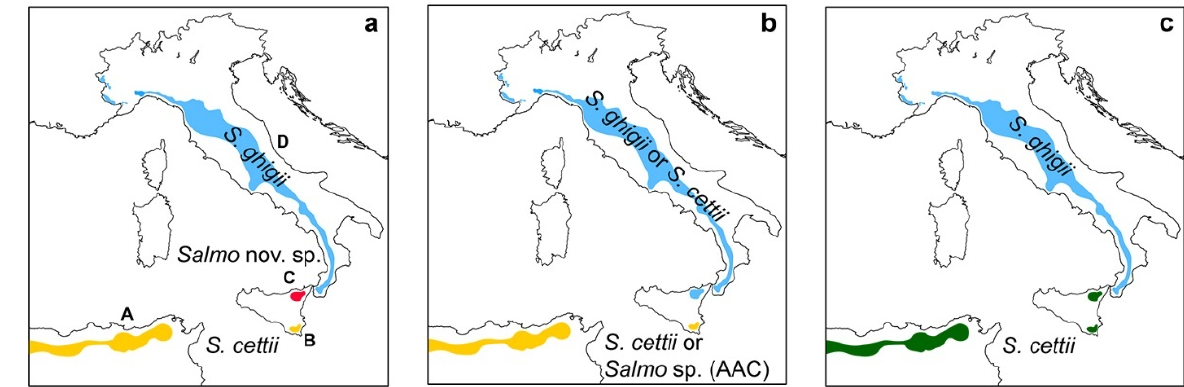
Figure 1. Three possible taxonomic scenarios (peninsular and Sicilian trouts, plus a North-African trout) if native trout samples are collected and analyzed from the Val Demone (no material presently available); ( a ) the native Val Demone population belongs to an undescribed and endemic lineage; ( b ) the native Val Demone population is conspecific with the peninsular trout; ( c ) the Val Demone and Val di Noto populations are conspecific. A: hypothetical distribution of a trout taxon of the “Afro-Atlantic clade” (AAC), conspecific with the Val di Noto trout population [40]; B and C: Val di Noto and Val Demone (likely extirpated [47]) populations, respectively, both described as S. cettii by Rafinesque-Schmalz [26]; D: peninsular trout, distribution range modified from [48]. No types are known for both S. ghigii and S. cettii . The taxon S. cettii is older than all North-African trout taxa [48].